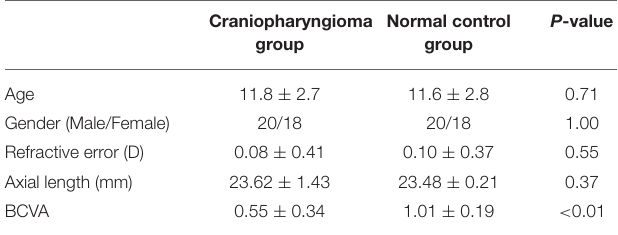
TABLE 1 | Comparison of general clinical data between craniopharyngioma group and normal control group ( ¯ x ±